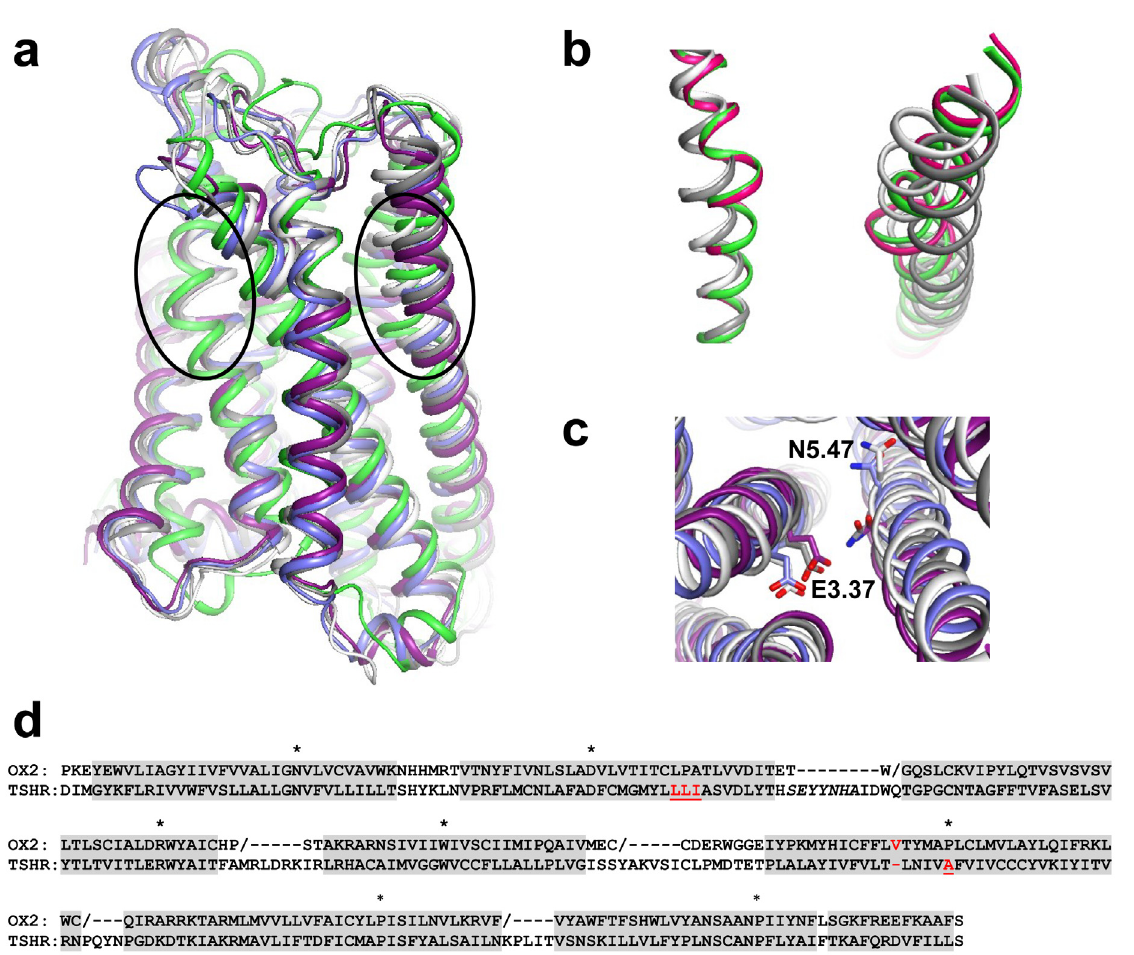
Fig 8. Dynamic modelling of the TSHR transmembrane domain. (a) Cartoon representation of TSHR transmembrane domain, obtained by homology modelling with the OX2 template, before and after simulations. The initial model is green. The snapshots obtained after 10, 20, 40 and 60 ns MD simulations are white, slate, grey and purple, respectively. The ovals indicate the positions of the distortions in TM2 and TM5. (b) TM2 (left) and TM5 (right) of the OX2 template (magenta) superimposed with the initial TSHR model (green) and with the snapshots obtained after 10 and 40 ns MD simulations (white and grey, respectively). (c) Close-up view of the relative orientation of the E3.37 and N5.47 side chains in the snapshots obtained after 10, 20, 40 and 60 ns MD simulations. (d) Sequence alignment between OX2 and TSHR used for homology modelling. The / symbol in the OX2 sequence indicates interruption of the sequence due to either missing residues in the crystal structure or residues not used for structural constraints in the modelling procedure. Helices are indicated by grey shading. The residues modeled with helical constraints in ECL1 are in italic. The positions of the anchors are indicated by stars. The position of the deletion in TM5 of OX2 is red. The positions of the proline substitutions in TSHR are red and